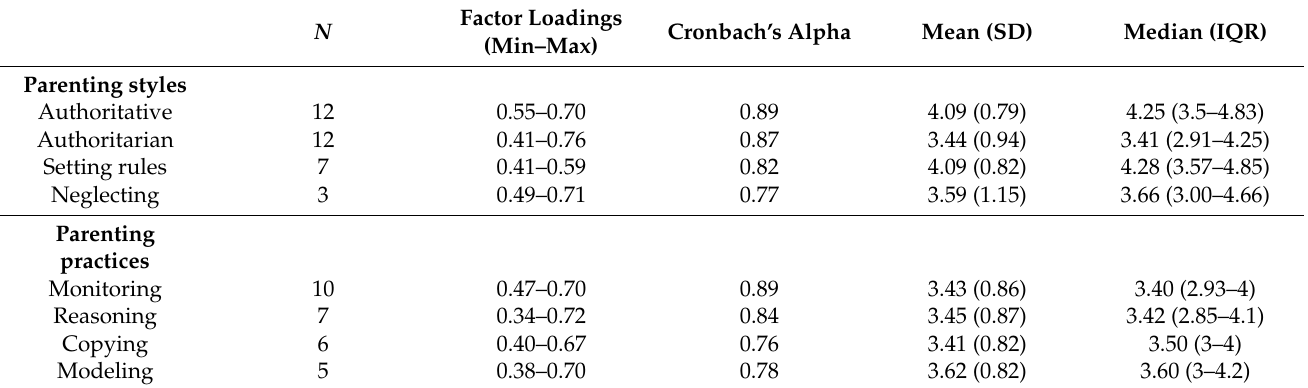
Table 4. Factor analysis to derive parenting